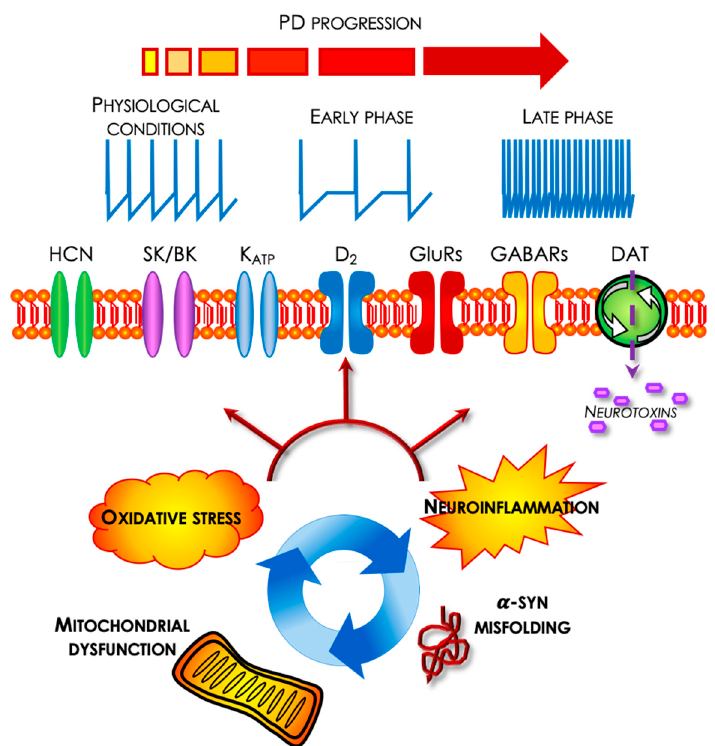
Figure 1. Schematic representation of the main cellular and molecular processes responsible for PD pathogenesis, including neurotoxic agents entering SNpc DAergic neurons through the DA transporter (DAT). During the course of PD progression, functional alterations occur in this neuronal population due to changes in the biophysical properties of several ionic channels, like HCN channels, responsible for I H , broad (BK) and small (SK) conductance Ca2+-dependent K+ channels, responsible for spike afterhyperpolarization (I AHP ) and ATP-dependent K+ channels. Alterations of the synaptic network also contribute to changes in membrane excitability involving glutamate and GABA transmission, as well as local D2 receptor-mediated auto-inhibition. Overall, these membrane mechanisms alter DAergic neurons’ resting membrane potential and firing discharge. Firing inhibition seems to characterize the initial stages of PD progression, possibly as an early defensive response against mitochondrial dysfunction, in order to preserve energy consumption. Conversely, later stages of PD progression appear to be mostly associated with an increase in membrane excitability, possibly in order to compensate for the loss of DA transmission, due to the ongoing neurodegenerative process eventually also affecting these hyperactive SNpc DAergic neurons.